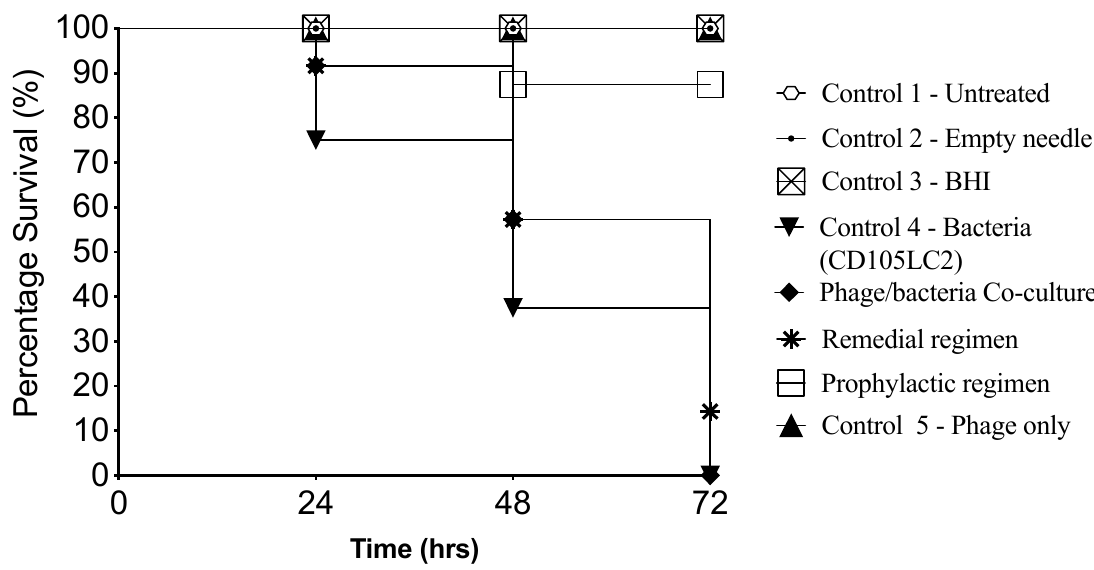
Figure 1. Kaplan–Meier survival curve of G. mellonella infected with CD105LC2, a clinically relevant ribotype 014 / 020 isolate, and treated with a 4-phage cocktail in 3 therapy regimens. The insects were treated prophylactically or remedially with the phage cocktail, or with a co-infection of the bacteria and phages. The treatment regimens were compared to Controls 1–5 for untreated insects, or those treated with empty needles, BHI, bacteria or phage cocktail, respectively, as shown in Figure 1 and Table 1. The prophylactic regimen performed best when compared with the remedial regimen ( p < 0.01) and co-infection group ( p < 0.01). Four larvae were examined per treatment group and the experiment was repeated on three occasions. Data was analysed using the Log Rank Mantel–Cox test in GraphPad Prism 8.